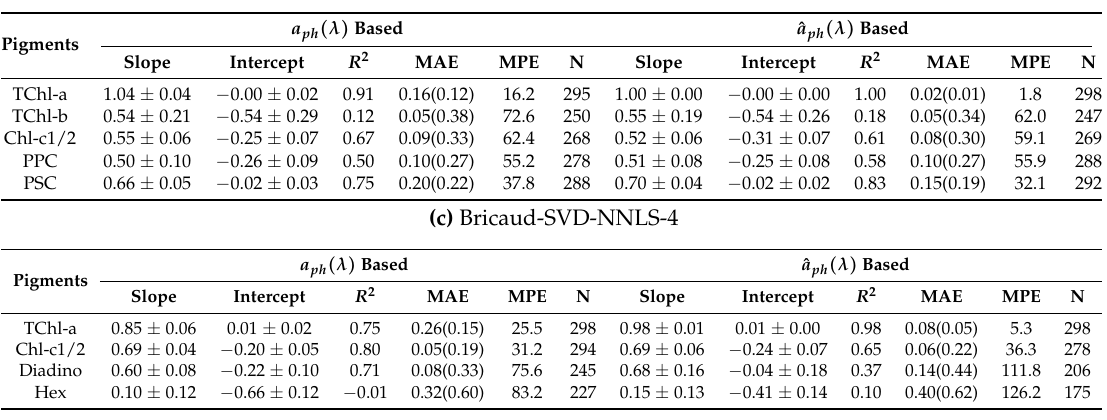
Table 4. Cont . (b) SVD-NNLS-5 (cid:48)